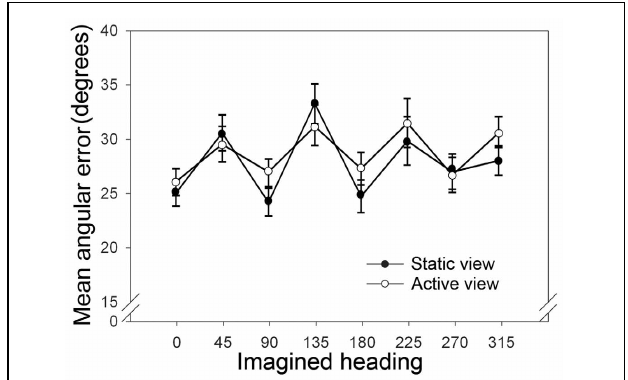
FIGURE 3 | Mean performance for the aligned and misaligned headings between the two learning conditions. Mean angular error in degrees for the aligned (white bar) and misaligned (gray bar) headings in Experiment 1A (static view) and Experiment 1B (active view). The brackets represent statistically significant differences between the two types of imagined headings (* p = 0 .